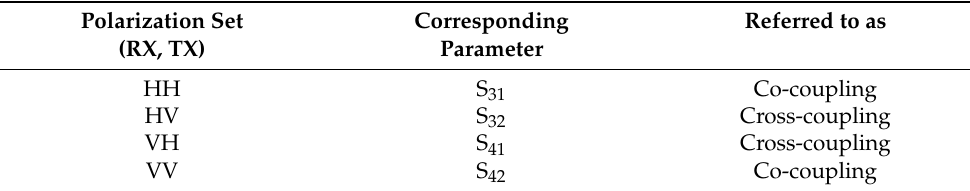
Table 1. Coupling parameters and corresponding description based on possible polarization